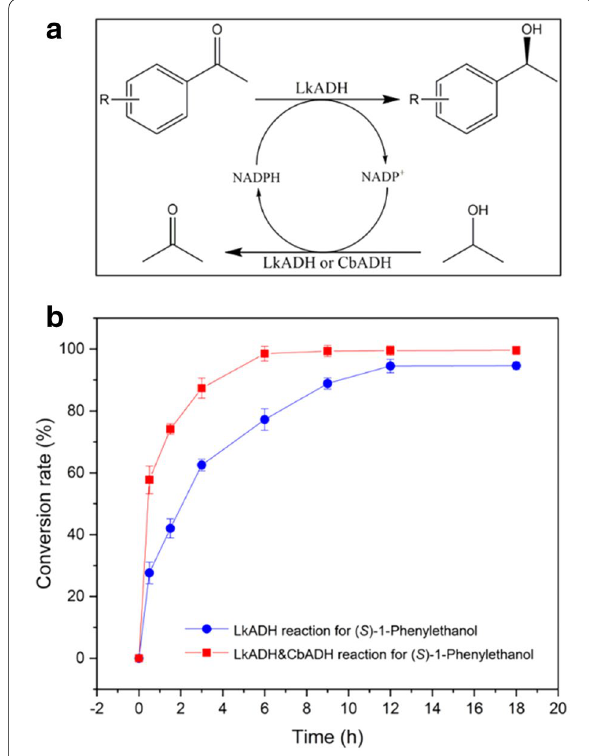
Fig. 8 The reduction of acetophenone for synthesis of (S) -1-phenylethanol. a LkADH mono-enzymatic reaction. b LkADH and CbADH (CbADH-6M) dual enzyme catalyzed